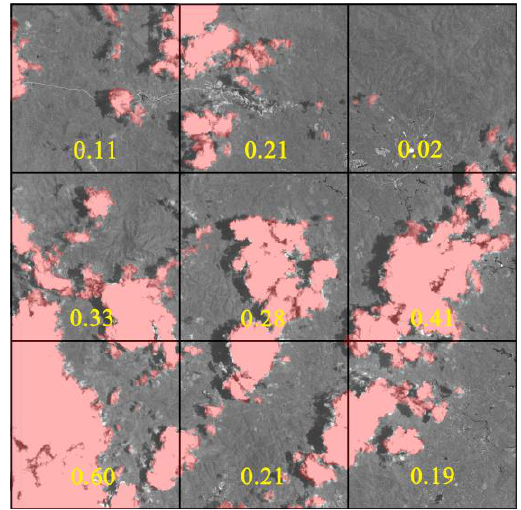
Figure 2. Sample of manually extracted cloud areas